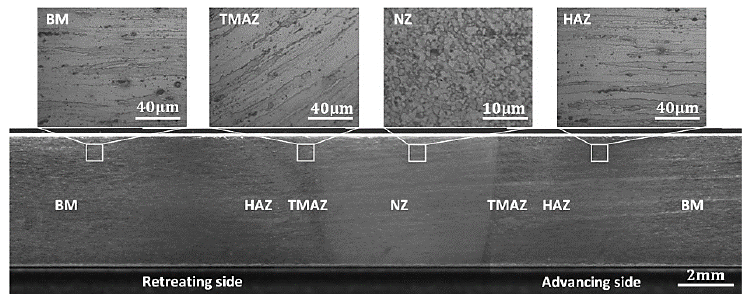
Figure 2. Metallographic cross-section of the FSW weld [23]. .